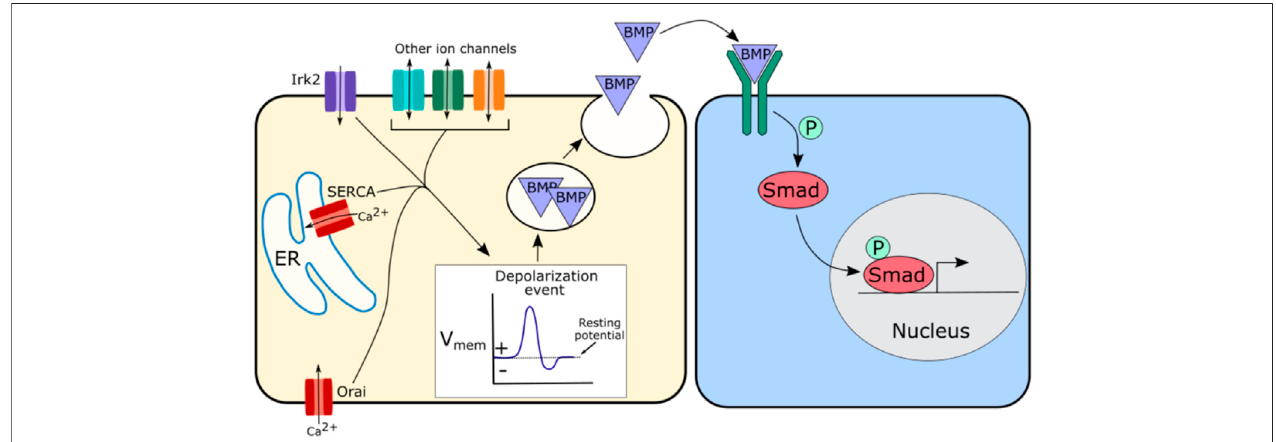
FIGURE 4 | Schematic of potential mechanism by which ion channels may regulate BMP signaling. Irk2, SERCA, and Orai have all been implicated in BMP signaling, but other channels are likely involved as well. A suggested hypothesis is that these ion channels regulate depolarization events that in turn regulate the release of BMP containing vesicles. This regulated release of BMP further regulates BMP pathway activity downstream by modulating the availability of morphogen levels.